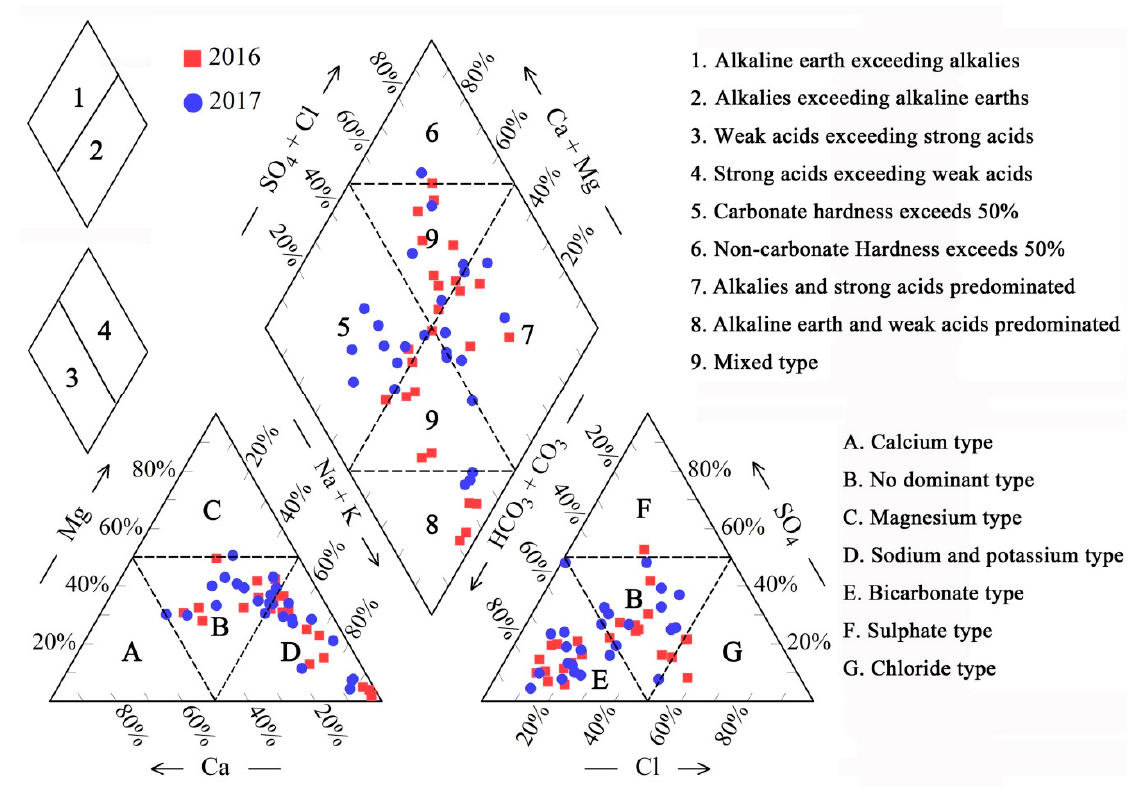
Figure 3 . Piper diagram of 50 groundwater samples. Figure 3. Piper diagram of 50 groundwater